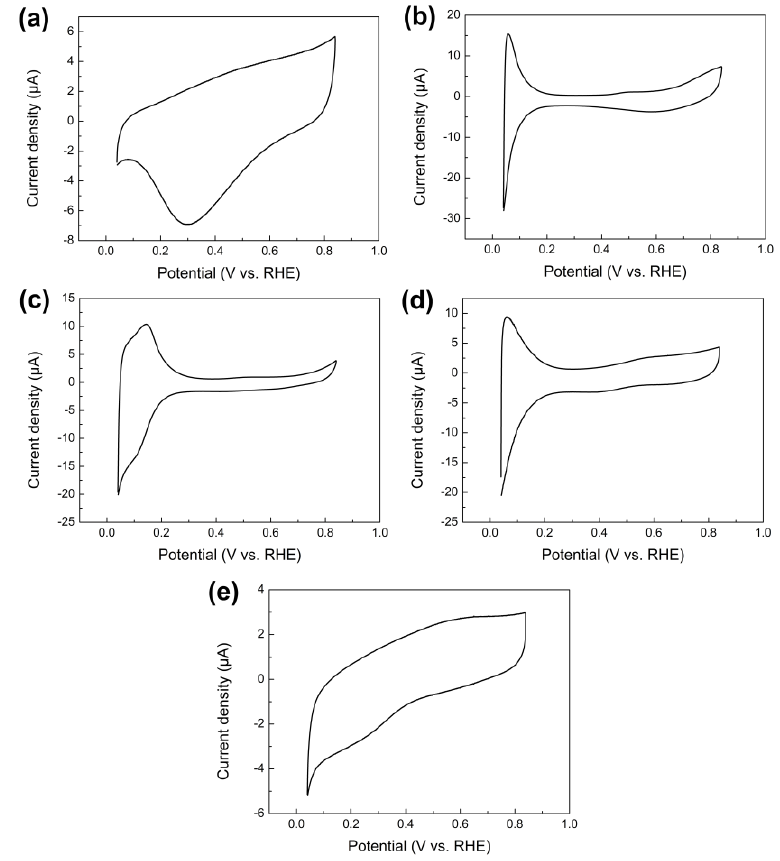
Figure 2. CVs measured on pure ( a ) Ru, ( b ) Rh, ( c ) Pd, ( d ) Ir, and ( e ) Au nanoparticles electrodeposited on the GCE in 0.5 M H 2 SO 4 solution at 0.05 V s −1 , respectively.